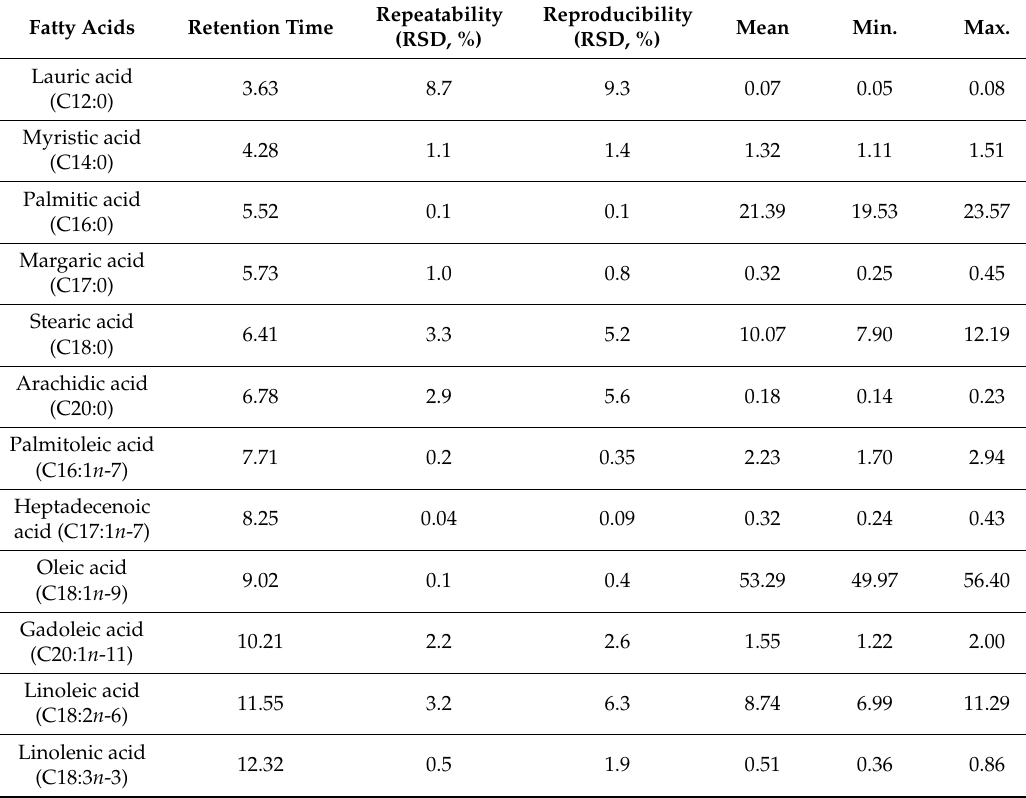
Table 1. Analytical performance of the gas chromatography-flame ionization detector (GC-FID) method in terms of repeatability and reproducibility. Mean, minimum, and maximum concentrations (expressed as percentage of total fatty acid methyl ester, FAME, content) found in Iberian ham samples under